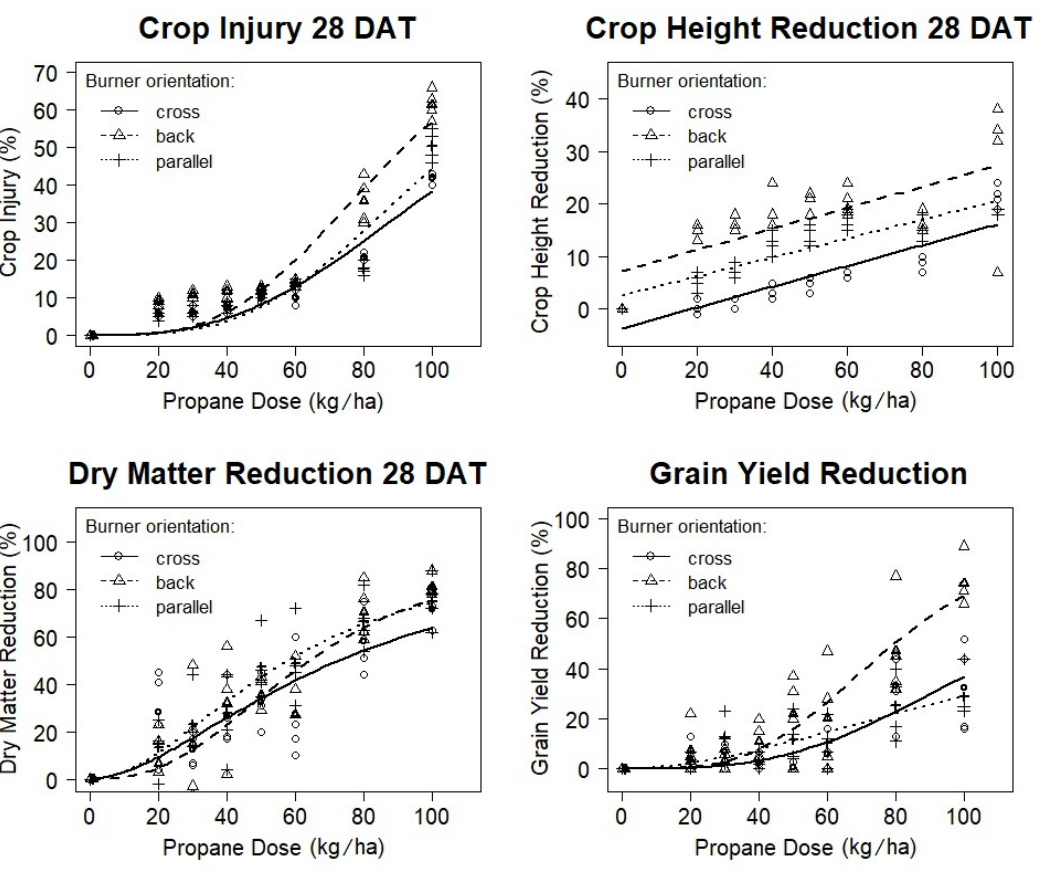
Figure 5. Soybean crop injury (%) 28 days after treatment (DAT), crop height reduction (%) 28 DAT, dry matter reduction (%) 28 DAT, and grain yield reduction (%) as affected by cross, back, and parallel burner orientation and propane doses (0–100 kg/ha); soybeans plants were flamed at V3 growth stage. Table 2. Regression parameters (±SE) for the response of soybean crop injury (%) 28 days after treatment (DAT), crop height reduction (%) 28 DAT, dry matter reduction (%) 28 DAT, and grain yield reduction (%) as affected by cross, back, and parallel burner orientation and dose of propane (0–100 kg/ha) (Figure 5). Predicted response of all evaluated parameters at 50 kg/ha propane dose are also included.